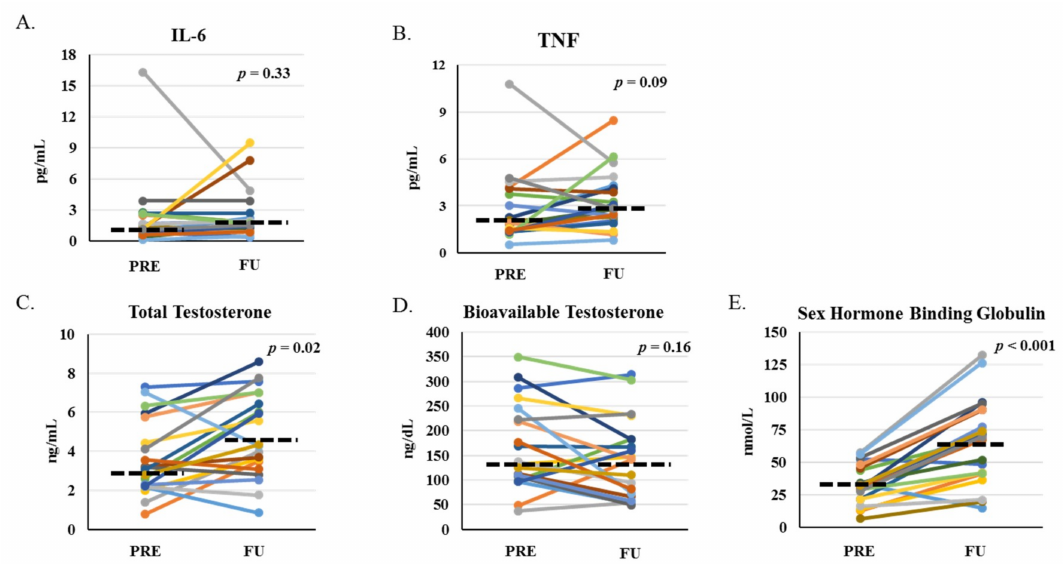
Figure 5. Biomarkers before and one-month after HCT. Circulating levels of inflammatory cytokines interleukin (IL)-6 ( A ) and tumor necrosis factor (TNF) ( B ) for men and women and anabolic markers: total testosterone ( C ) and calculated bioavailable testosterone ( D ) for men only, and sex-hormone binding globulin ( E ) for men only at PRE and FU. p -values indicate paired-sample comparison between PRE and FU. Dashed lined represent median at PRE and